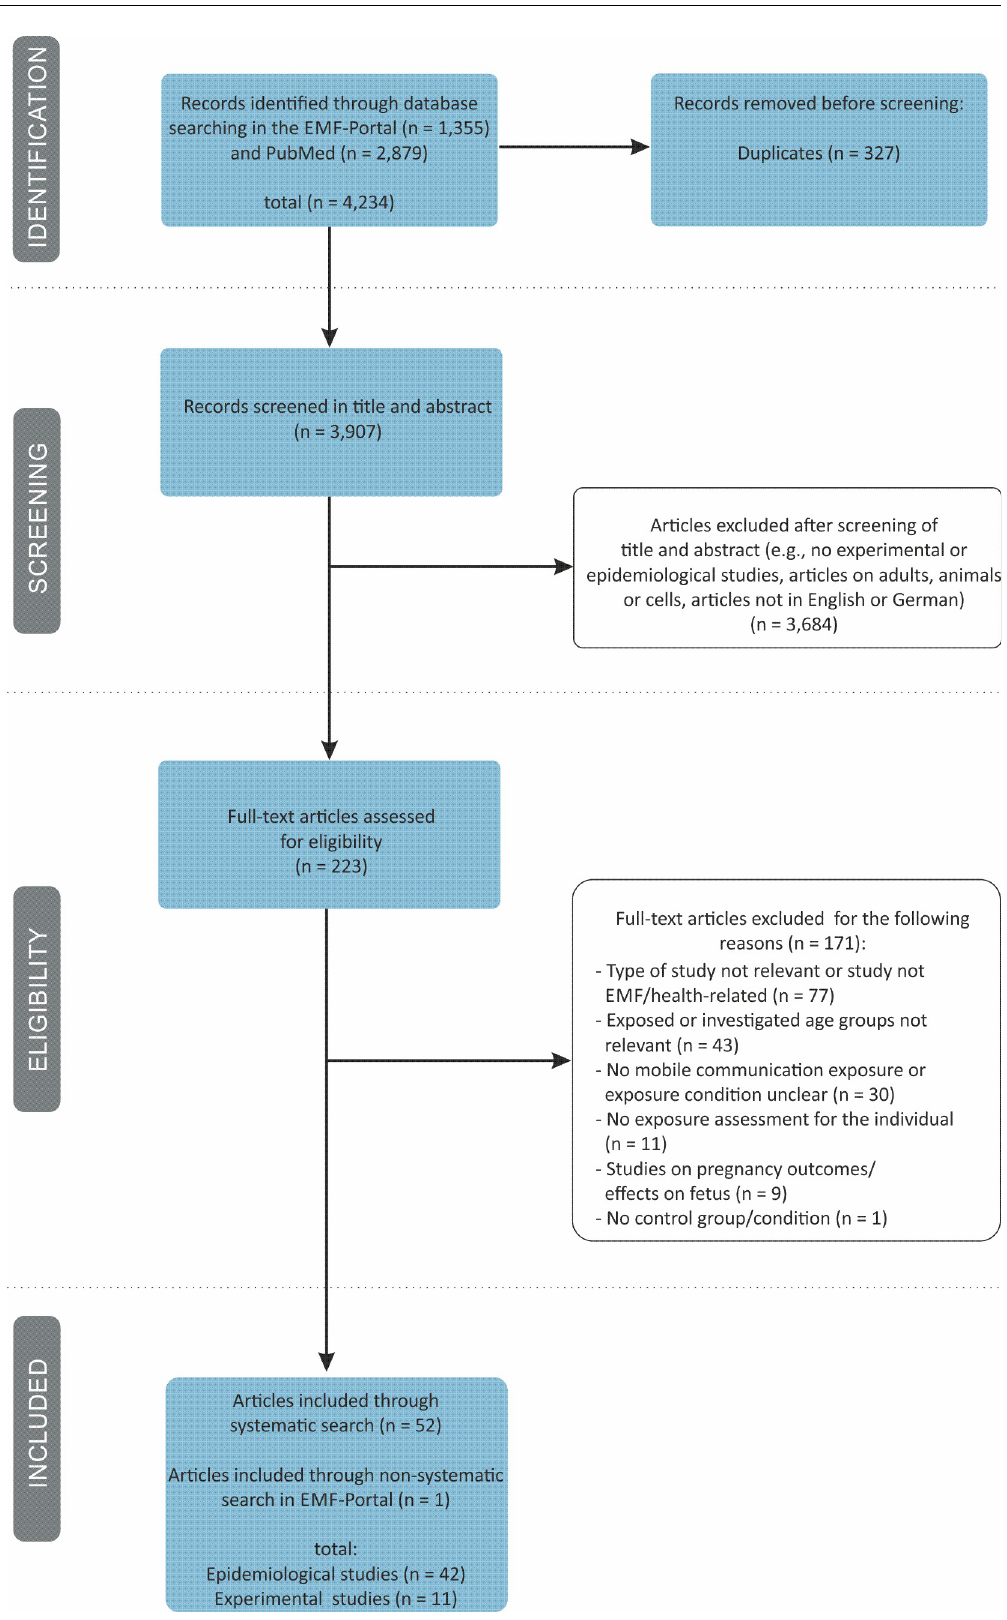
Fig 1. Flow diagram of literature search, eligibility and inclusion process according to PRISMA statement.